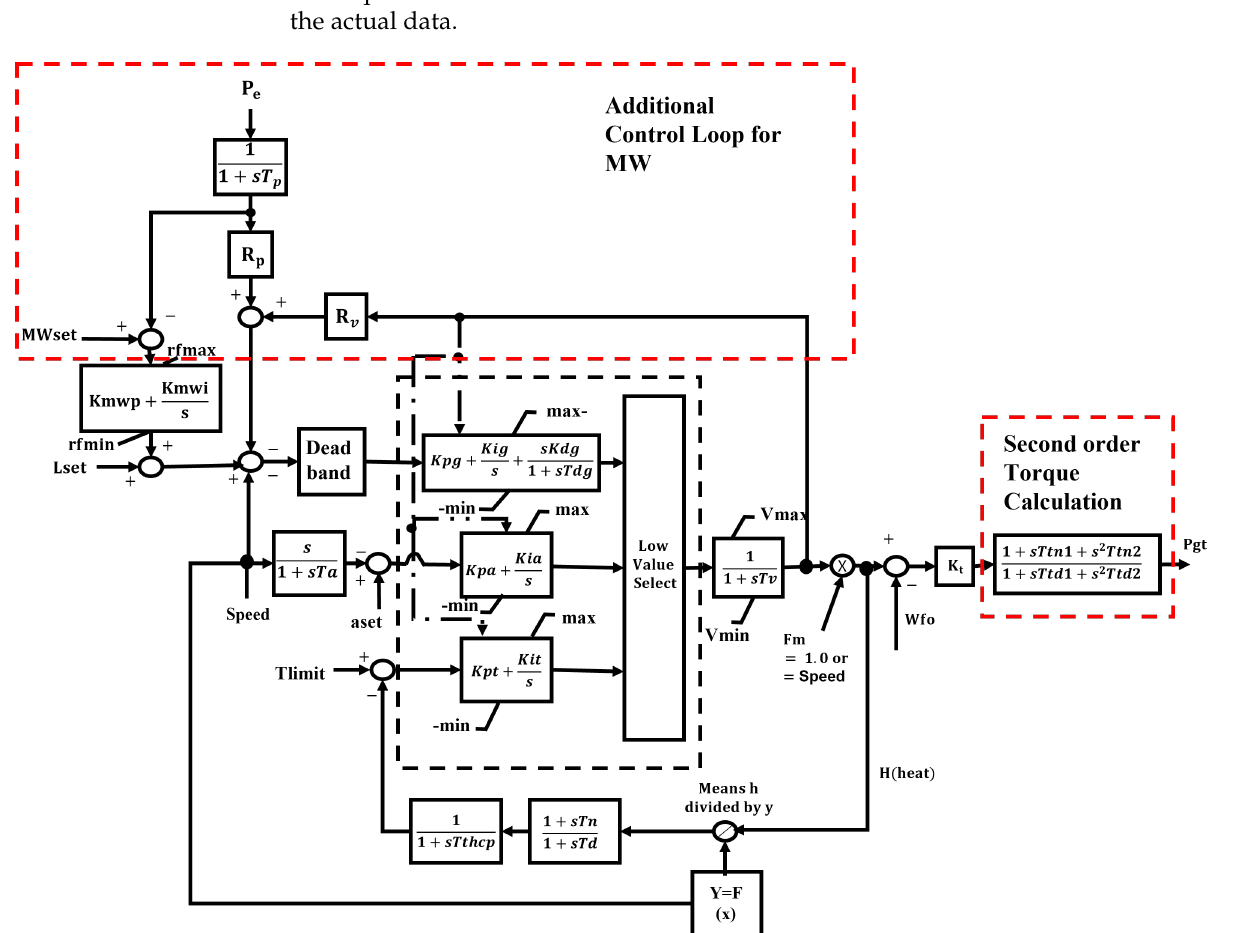
Figure 10. CIGRE model for combine-cycle gas turbine operation [58].